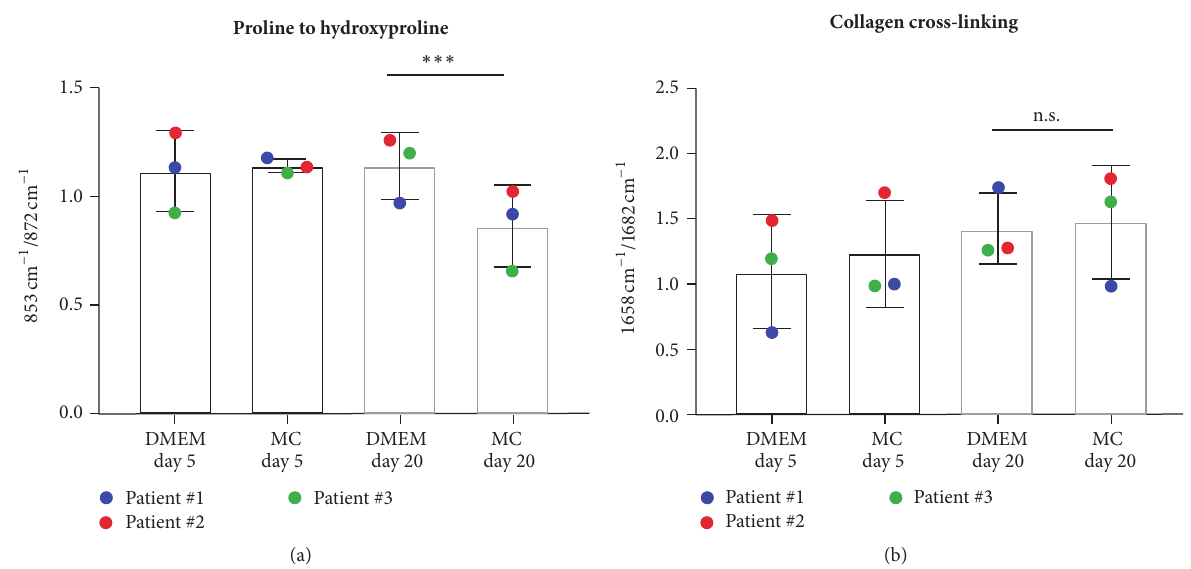
Figure 6: Spectral ratios to assess the maturity degree of collagen formed at mineralized sites in DMEM and serum-free cultured MSCA- 1 + JPCs. (a) Proline to hydroxyproline ratio (853/872 cm −1 ) indicating significant differences in maturation of collagen fibrils due to media conditions after 20 days of differentiation (statistical significance is indicated by asterisk: ∗∗∗ 𝑝 < 0.001 ). (b) Collagen cross-linking calculated from the 1658/1682 cm −1 ratio (n.s., not statistically